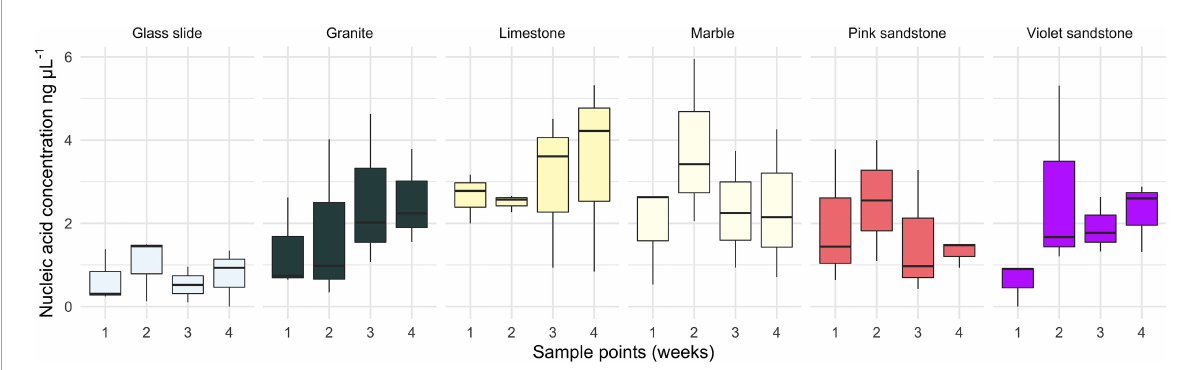
on the Prokaryotic composition based on 16S rRNA marker genes [PERMANOVA, F ( 7 , 181 ) = 1.203, p = 0.066; Figure 2